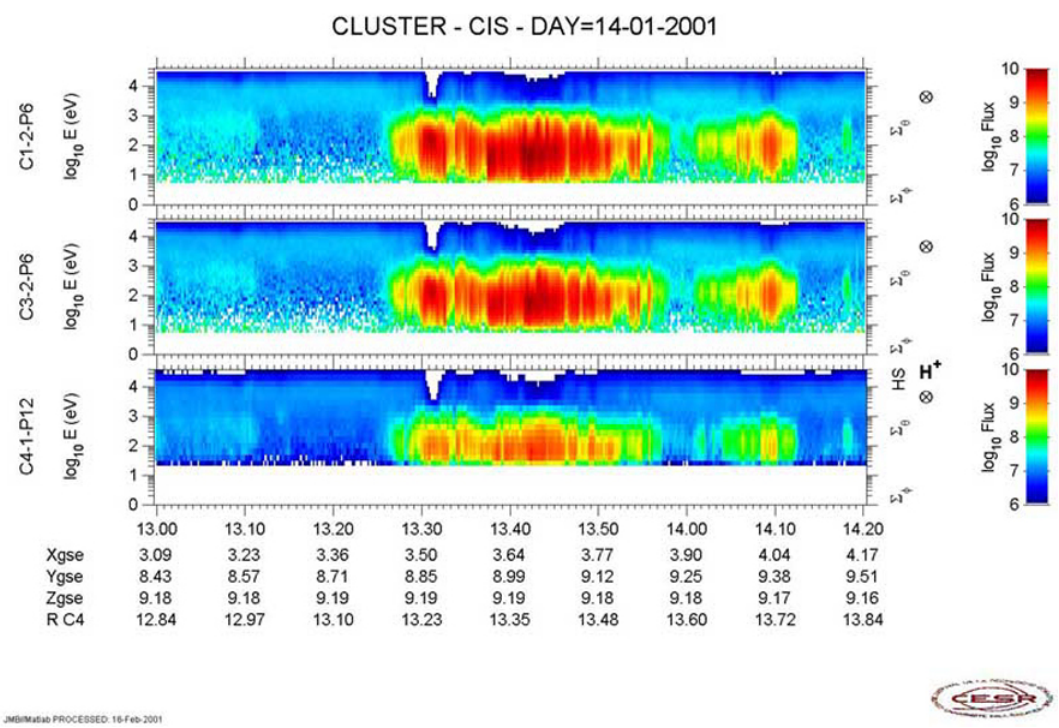
Fig. 16. CIS data of the total ion fluxes versus energy for Cluster spacecraft1, 3, and 4, illustrating the variations between spacecraft1, 3 and